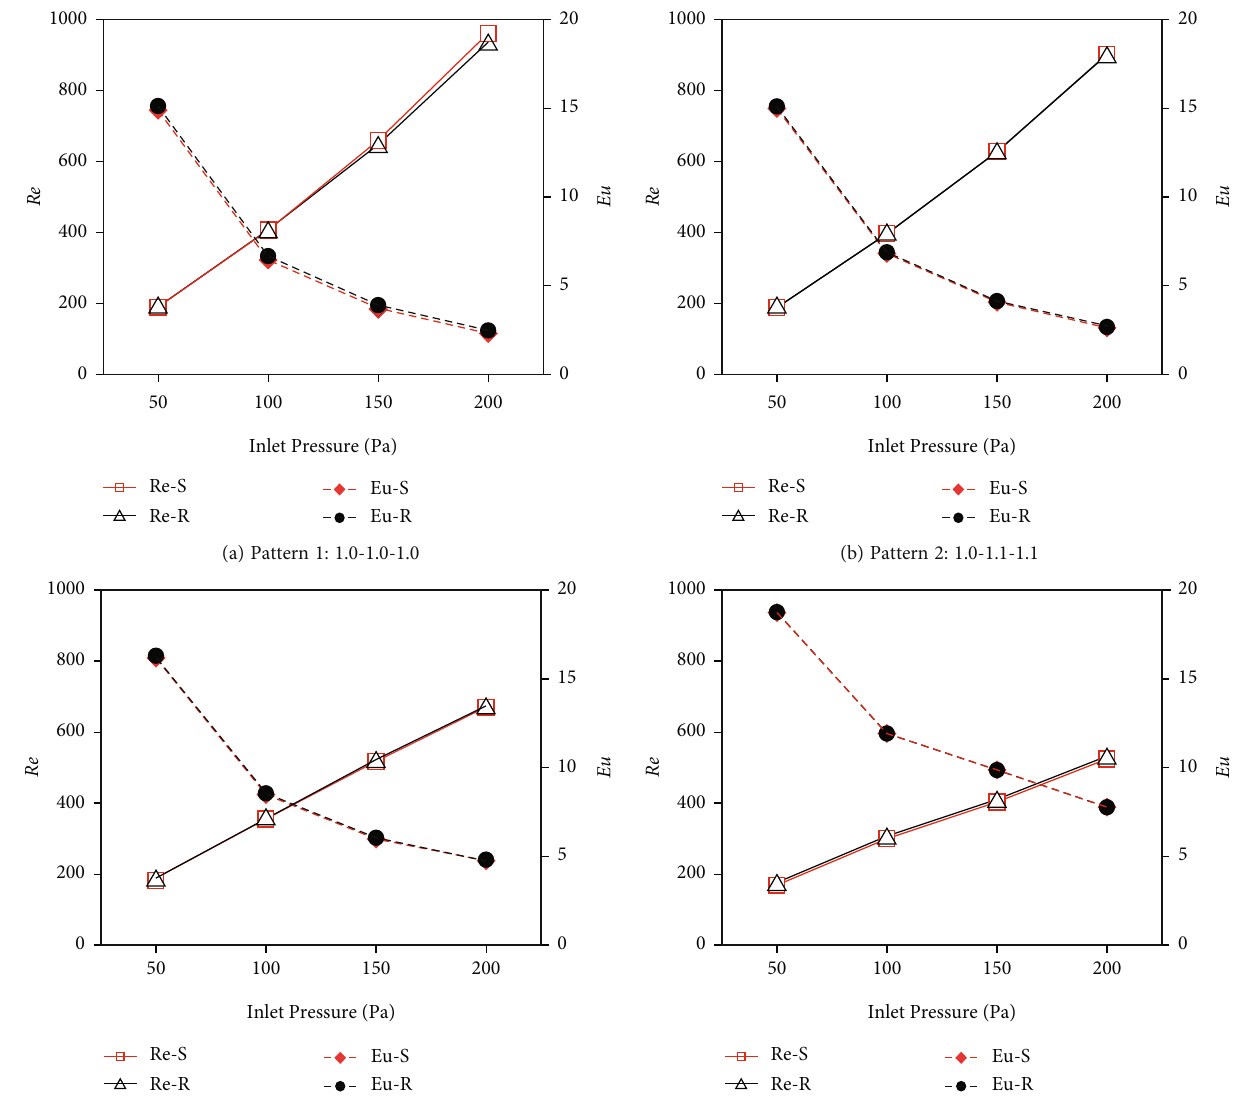
= D ). Re-S and Re-R represent the Reynolds number of the smooth and rough branch fracture. Eu-S B C